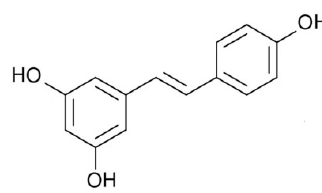
Figure 1. Chemical structure of trans- resveratrol (3,5,4 ′ -trihydroxy- trans -stilbene).